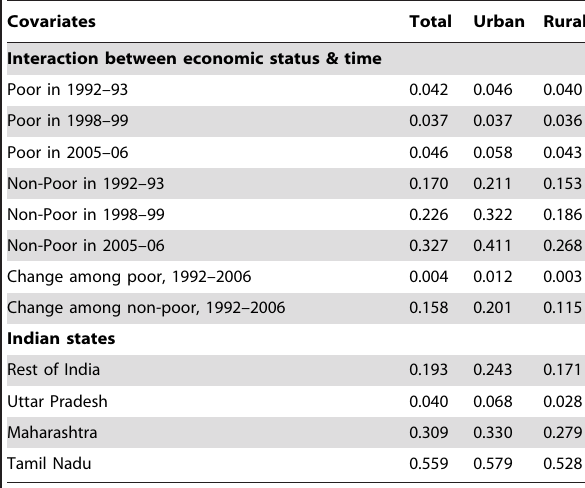
Table 6. Predicted probabilities of prenatal care adjusted for socioeconomic & demographic characteristics, India, 1992– 2006 { .